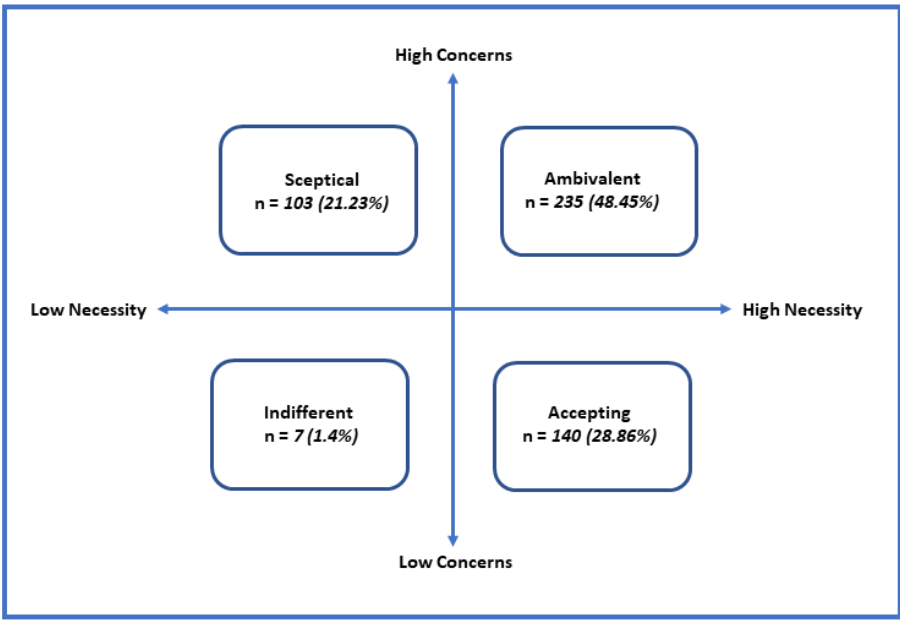
Figure 1. Attitudinal analysis of BMQ-specific findings in the studied